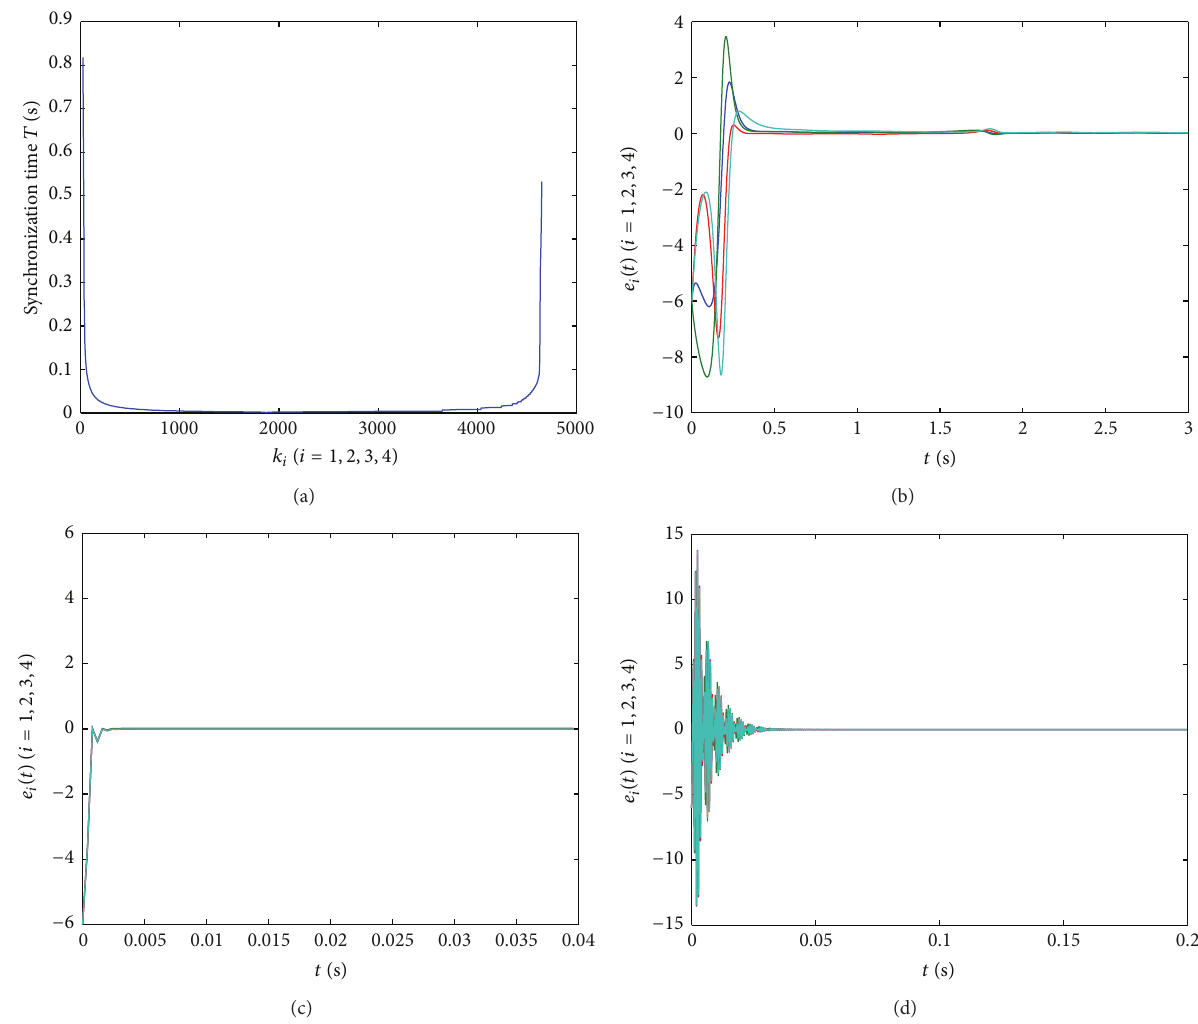
Figure 3: The waveform of synchronization time with the control parameters 𝑘 𝑖 (𝑖 = 1,2,3,4) (a) and time waveforms of synchronization errors between two hyperchaotic Chen systems with parameter 𝑘 𝑖 = 15 (b), 1875 (c), 4500 (d) ( 𝑖 = 1, 2,3, 4 ), respectively.